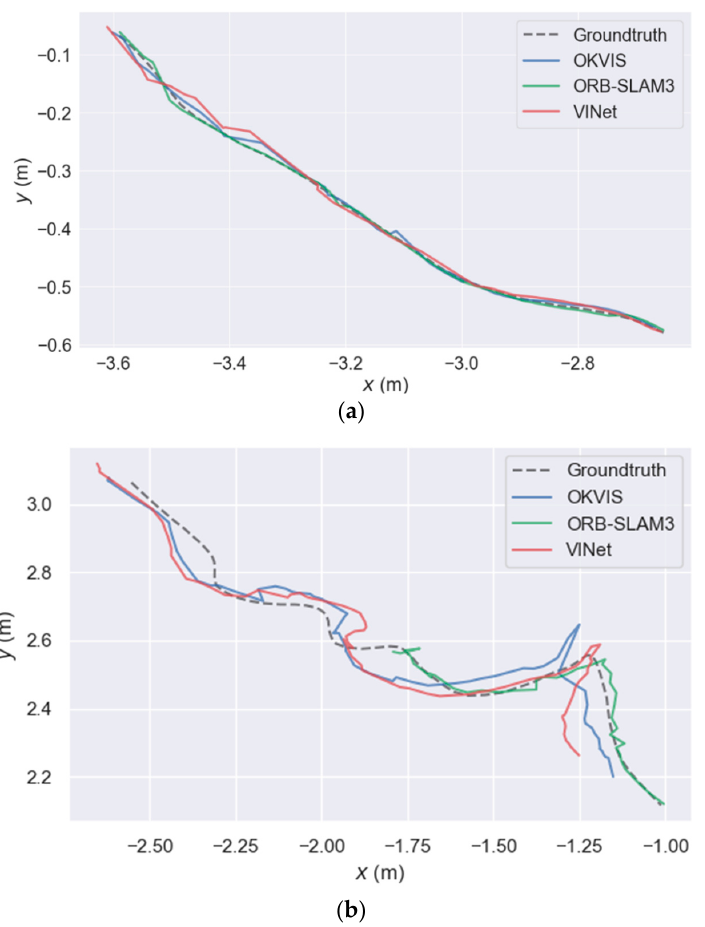
Figure 7. Trajectory comparison of vision–inertial methods. ( a ) Sequence 1. ( b ) Sequence 7.